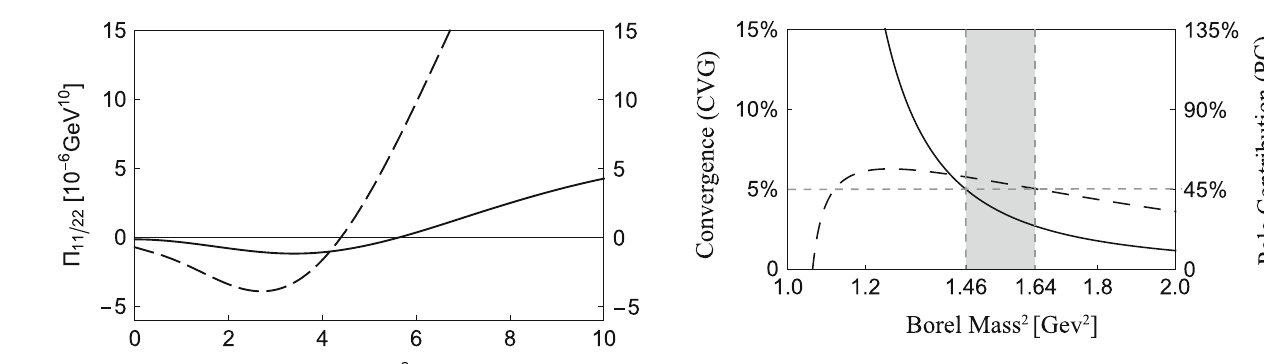
Fig. 2 CVG (solid curve, defined in Eq. 26) and PC (dashed curve, defined in Eq. 27) as functions of the Borel mass M B . These curves are ) (solid) and Fig. 1 The two-point correlation functions, Π 11 ( s 0 , M 2 obtained using the single current η 1 when setting s 0 = 8 . 8 GeV 2 B Π ( s , M 2 ) (dashed), as functions of the threshold value s 22 0 0 . These B = 1 . 5 GeV 2 curves are obtained by setting M 2 B This is the cornerstone of a reliable QCD sum rule